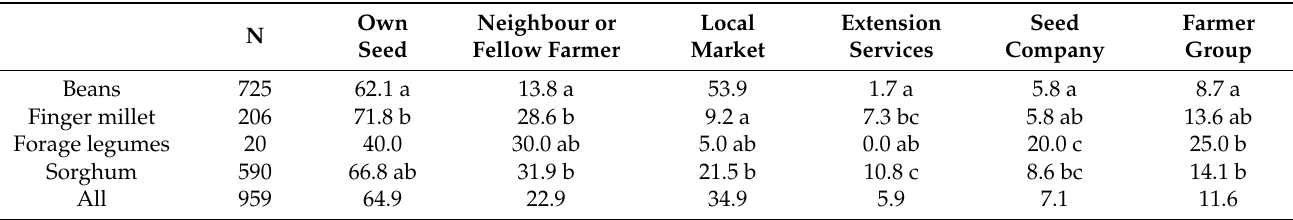
Table 2. Sources of seed by crop (% of respondents) a , (a gender-disaggregated analysis is presented in Appendix A Figure A1 and Table A3).